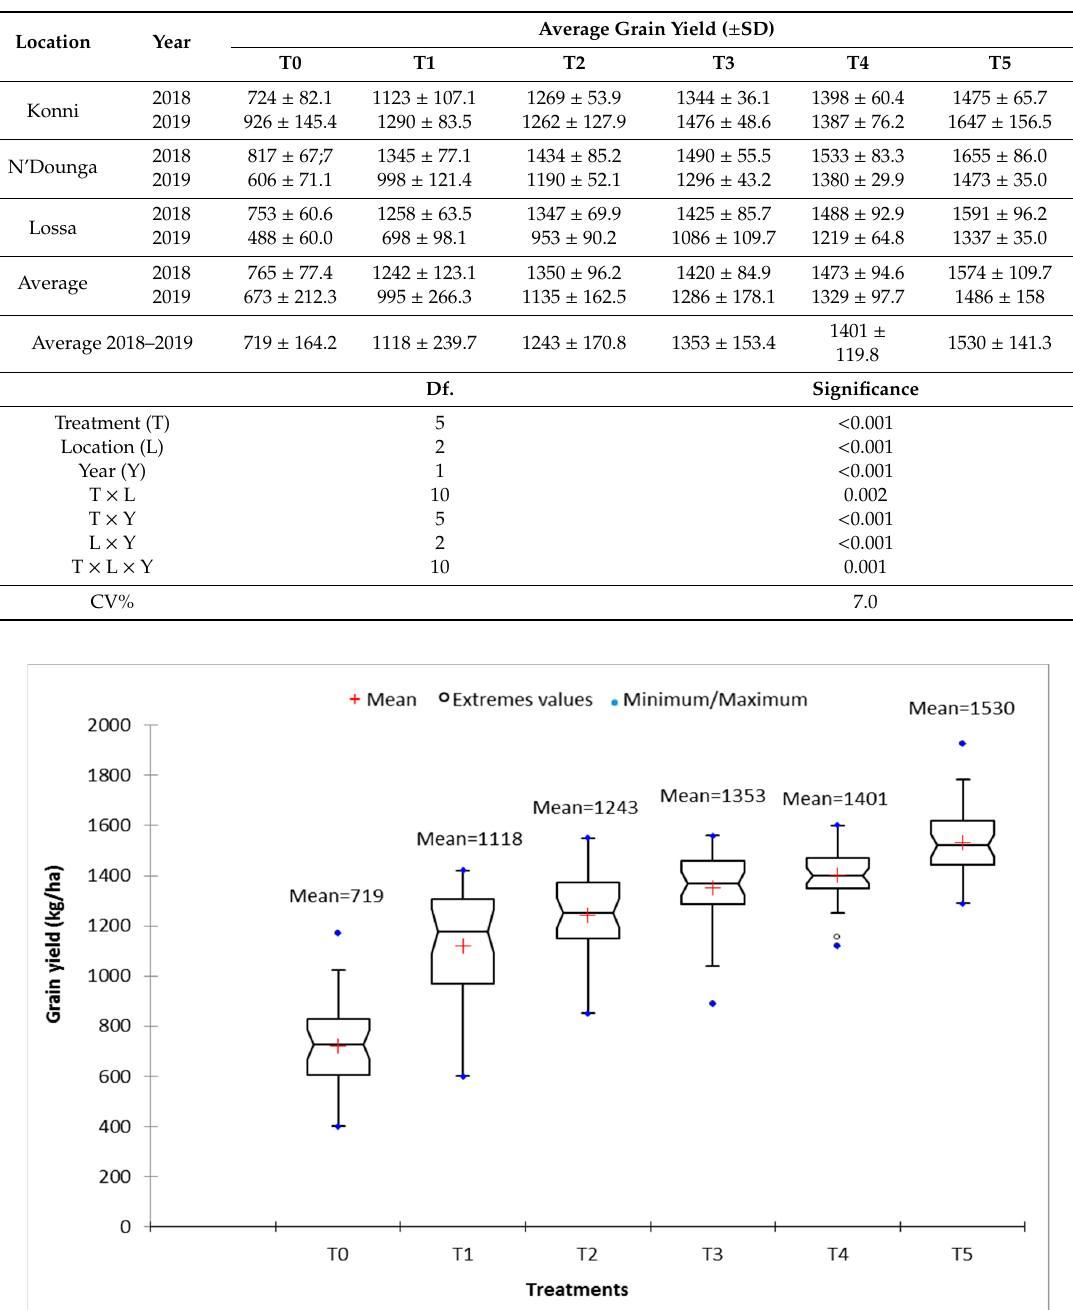
Table 5. E ff ects of the treatments on pearl millet grain yield (kg ha − 1 ). Averages of treatments and corresponding 95% confidence intervals are presented.